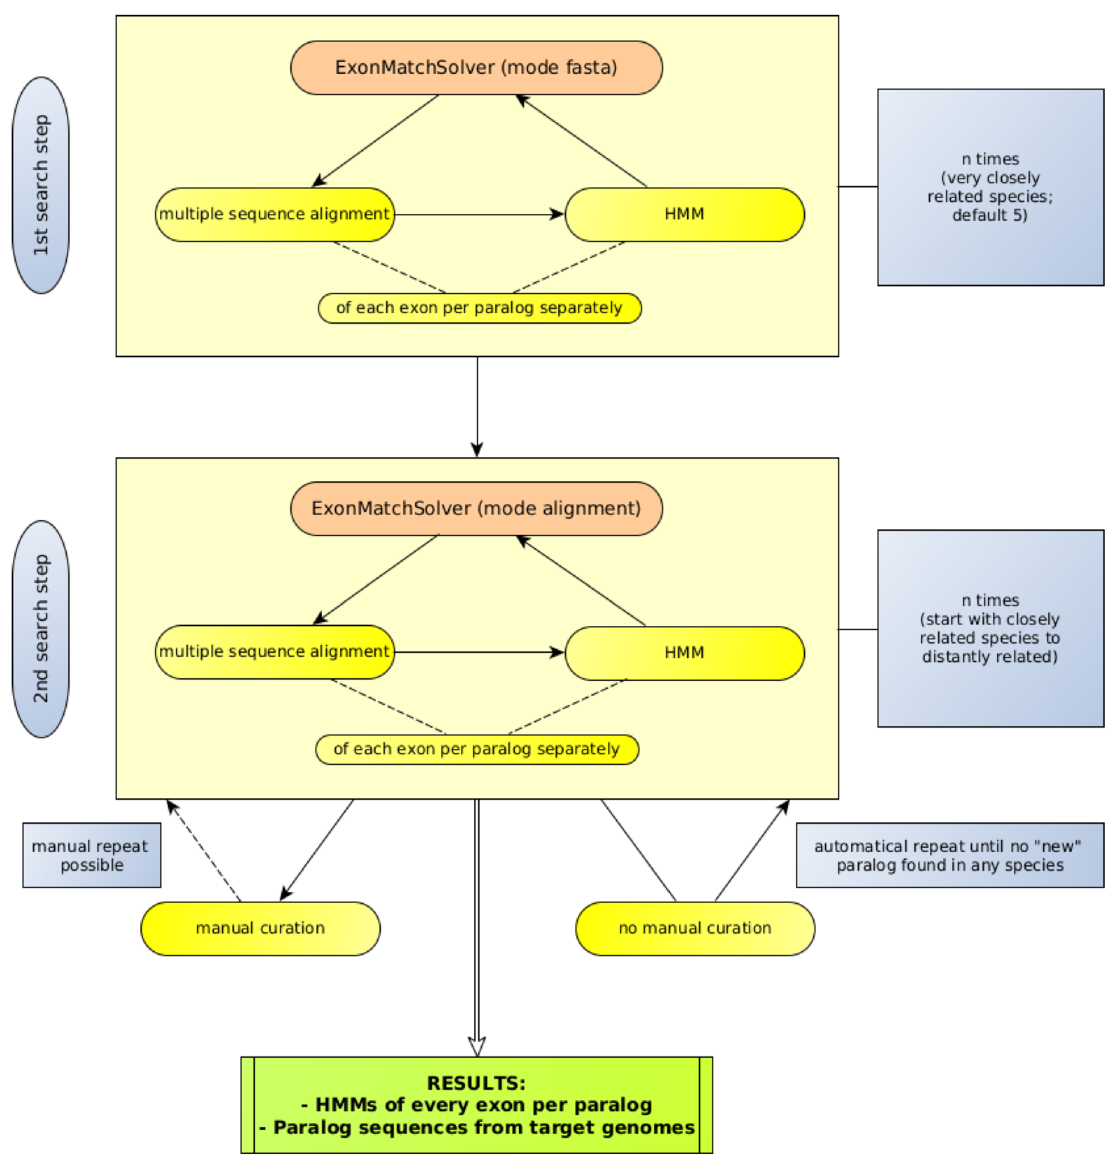
Figure 3: Automation. The automation of the ExonMatchSolver (EMS) search in a group of species is divided in two steps. First search with the mode fasta of the EMS to create the hidden Markov models (HMMs) for the second search step which uses the alignment mode of the EMS. The second search step is repeated with all species still lacking at least one of the sought paralogs until no new paralog sequence is found in any